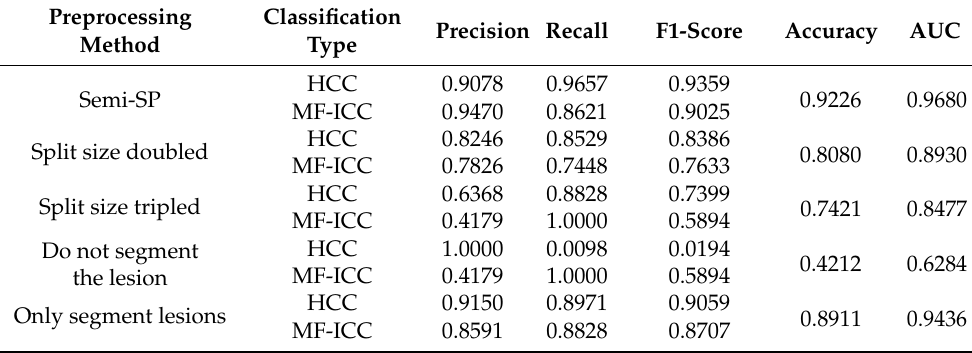
Table 1. Comparative experiments of different preprocessing methods.